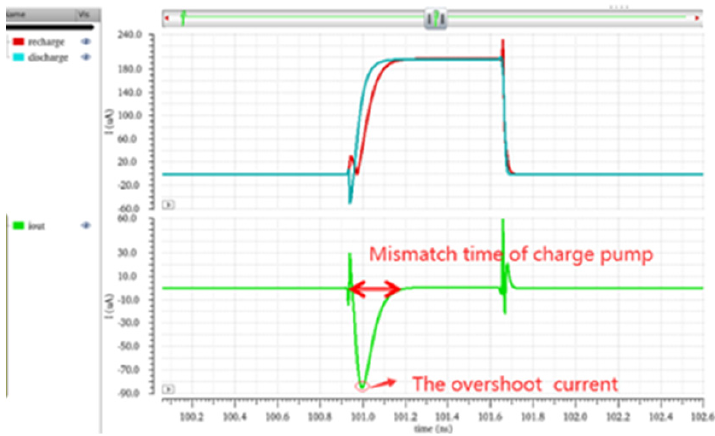
Figure 3. Parasitics’ impacts on charge/discharge.